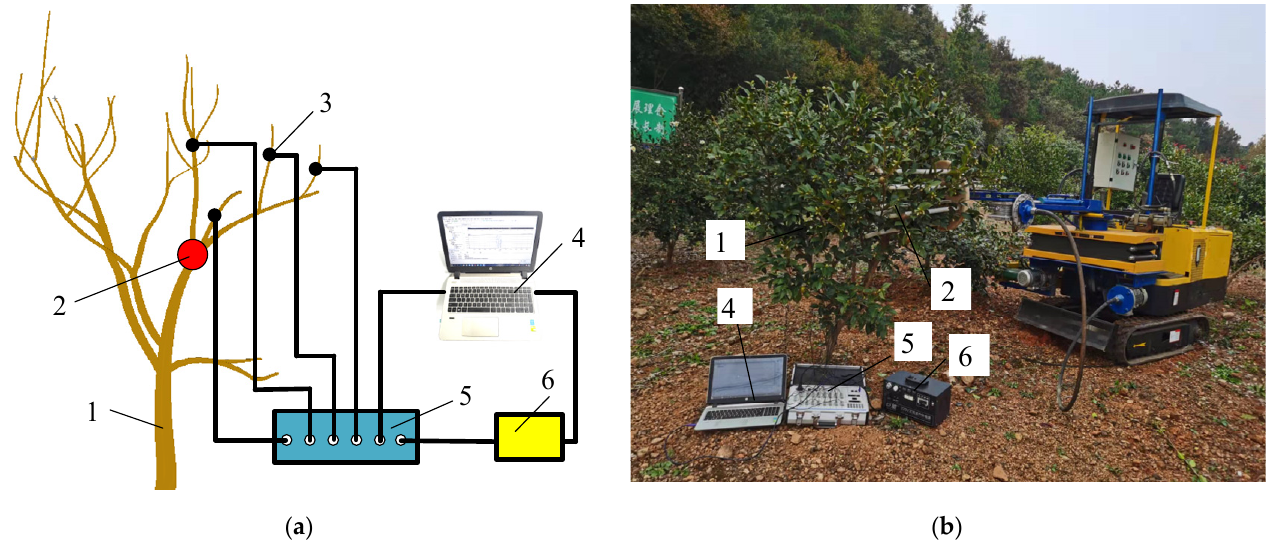
Figure 4. ( a ) Schematic diagram of data acquisition; ( b ) Test diagram of data acquisition. 1. Camellia oleifera tree; 2. Excitation position; 3. Acceleration sensor and strain gauge; 4. Computer; 5. Signal acquisition instrument; 6. Portable power source.